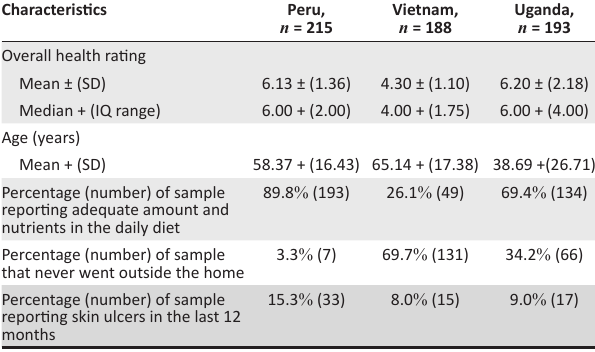
FIGURE 2: The FWM GEN_2 wheelchair. TABLE 2: Demographics of original sample by